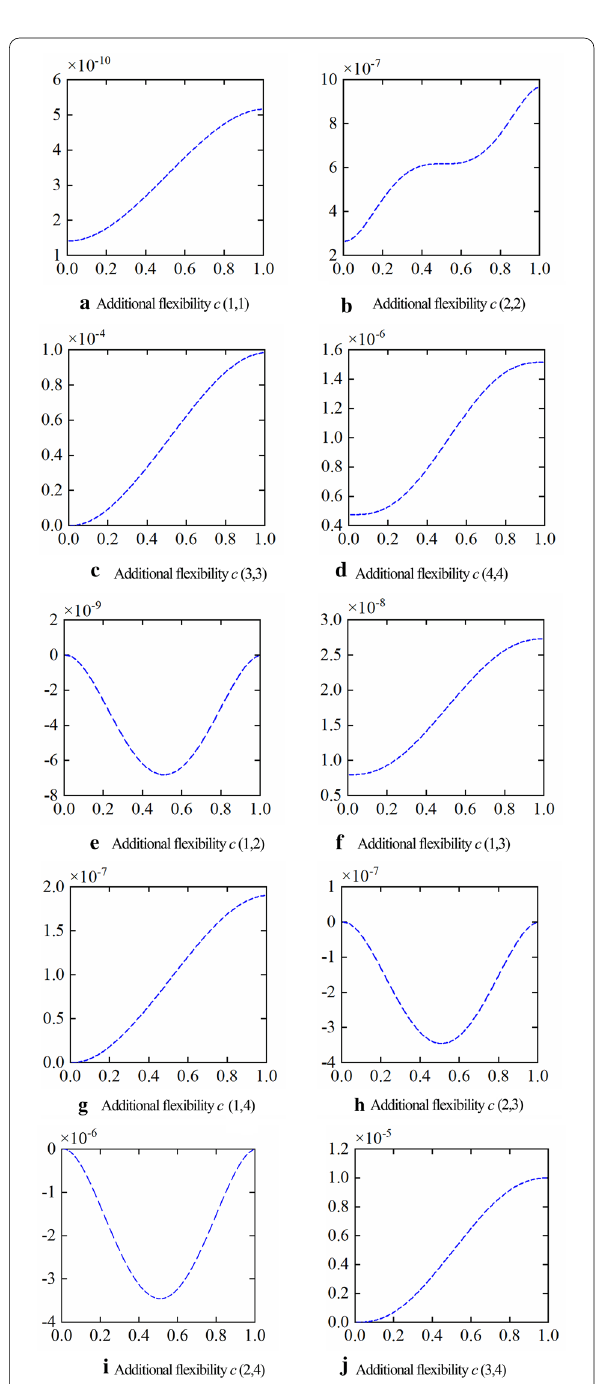
Figure 3 Additional flexibility of rotor system with a slant